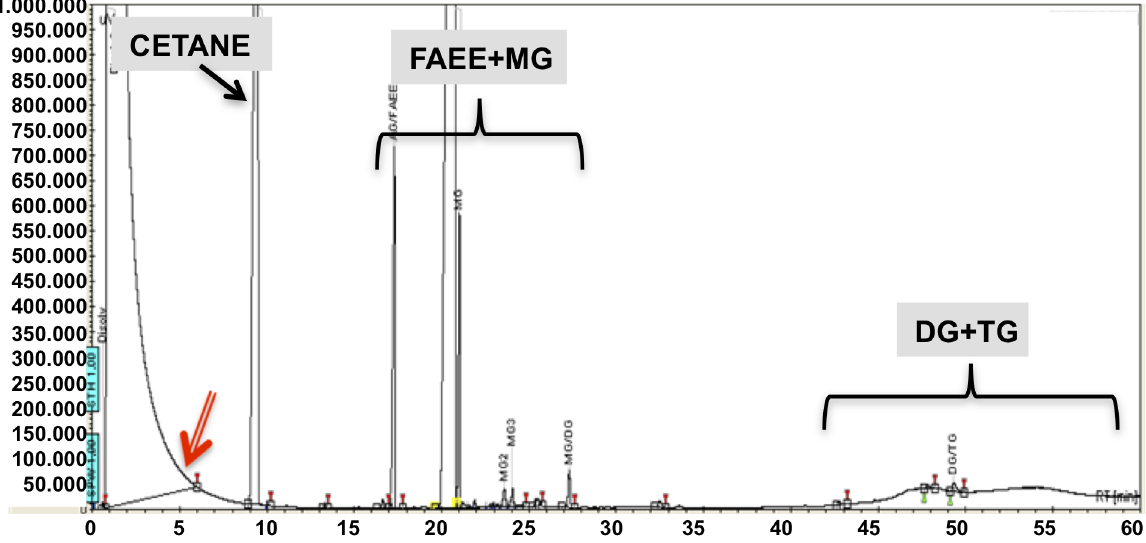
Figure 1. Chromatogram obtained by GC of the reaction mix after the transesterification of sunflower oil and ethanol performed by the processed supernatant of strain AE2B 122. Cetane was used as an internal standard. FAEE: Fatty Acid Ethyl Ester; MG: MonoGlyceride; DG: DiGlyceride; TG: TriGlyceride. The double-lined arrow indicates the retention time expected for glycerol as previously reported [5,6]. doi:10.1371/journal.pone.0104063.g001 PLOS ONE |